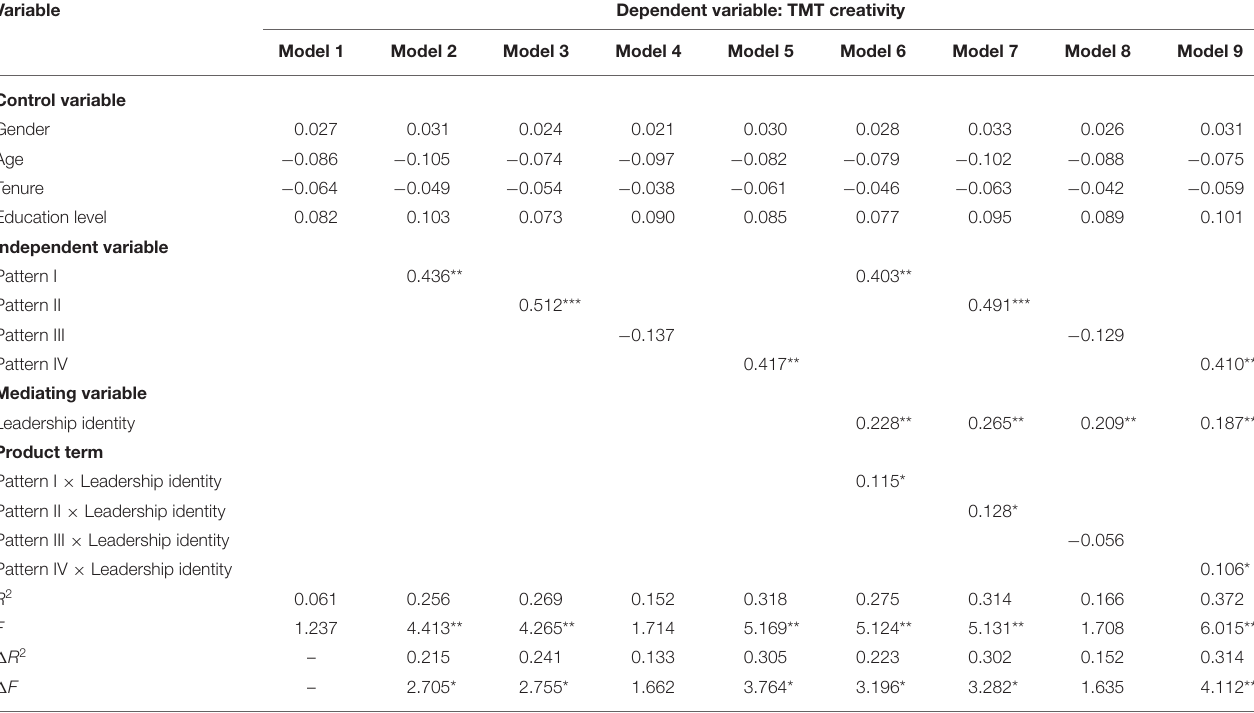
TABLE 3 | Multiple regression analysis.